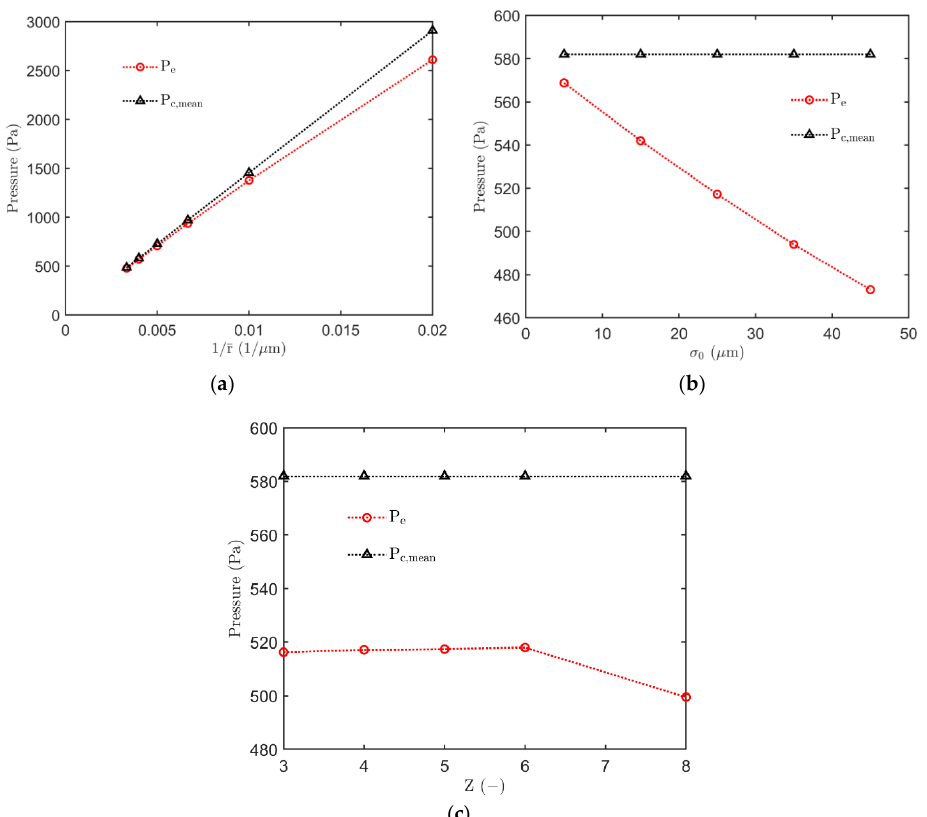
Figure 6. Relationship of entry pressure ( P e ) and mean capillary pressure ( P c,mean ) with specific properties of the porous medium: ( a ) influence of mean radius with identical standard deviation (5 µm) and a connectivity of 6; ( b ) influence of standard deviation with constant mean radius (250 µm) and a connectivity of 6; ( c ) influence of connectivity with the constant ratio 𝜎 0 /𝑟 ̅ = 25/250 (µm). Simulation results have been averaged over 40 realizations.